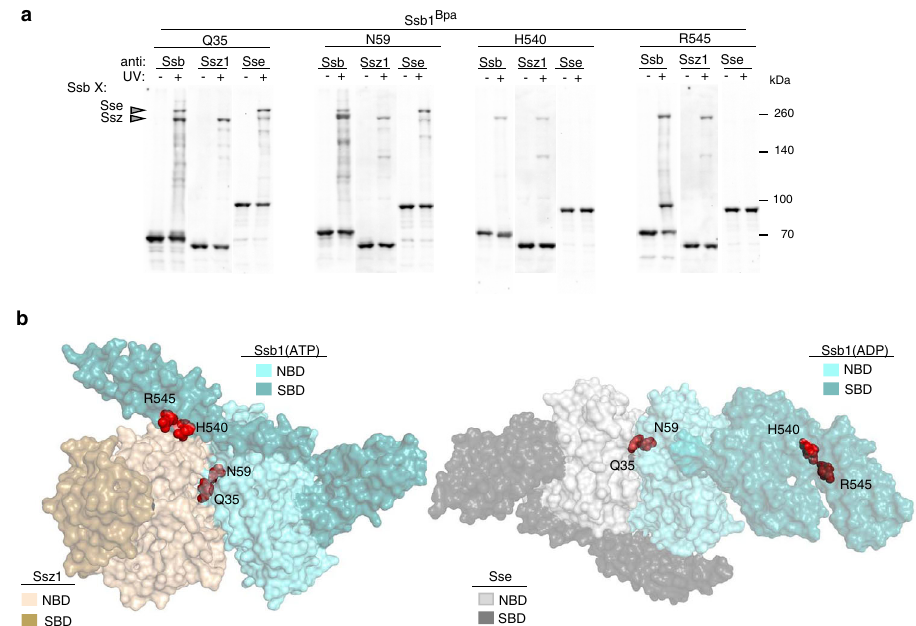
Fig. 2 Ssb1 cross-links to Ssz1 and Sse. a Cross-linking of Ssb1 Bpa variants. Cells expressing Ssb1 with Bpa incorporated at indicated positions were exposed to UV light ( + ) or left unexposed ( – ). Cross-linking was analyzed by immunoblotting after SDS-PAGE using antibodies speci fi c for (anti) Ssb, Ssz1, or Sse. Ssb1 cross-links to Ssz1 or Ssb cross-link (X) products are indicated with arrowheads. Migration of molecular weight markers (kDa) is indicated by dashes. Uncropped blots are provided as a Source Data fi le. Three or more independent strains were analyzed for each Bpa variant, with similar results. b Models of Ssb1(ATP) – Ssz1 heterodimer, as in Fig. 1d, and Ssb1 – Sse1 heterodimer derived from Sse1-human Hsp70 NBD (PDB 3D2F), and modeled using Ssb1 NBD (PDB 3GL1) and DnaK SBD (PDB 2KHO). Ssb1 positions that cross-linked to either Ssz1 (H540 and R545) or Ssz1 and Sse1 (Q35 and N59) in sphere representation (red).